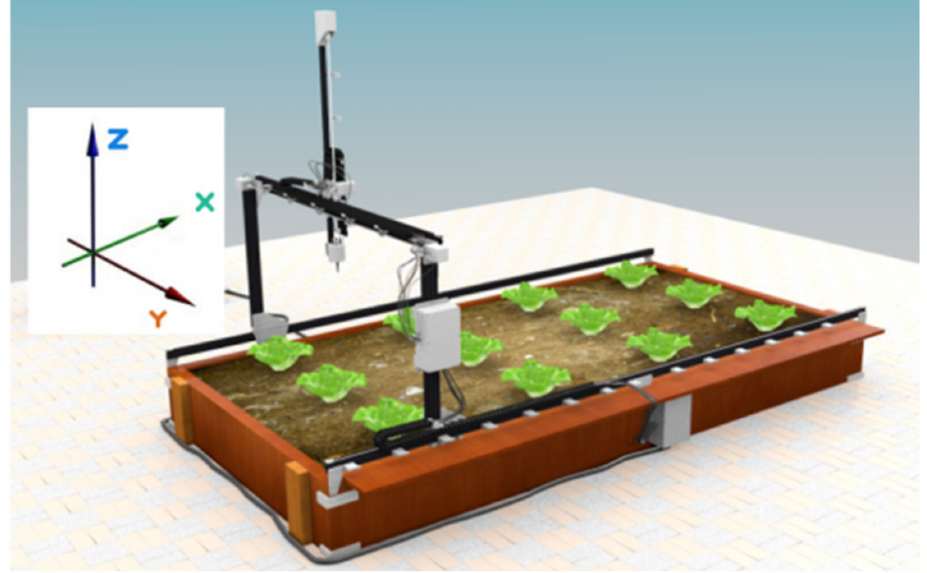
Figure 1. Plain schematic of CityVeg’s